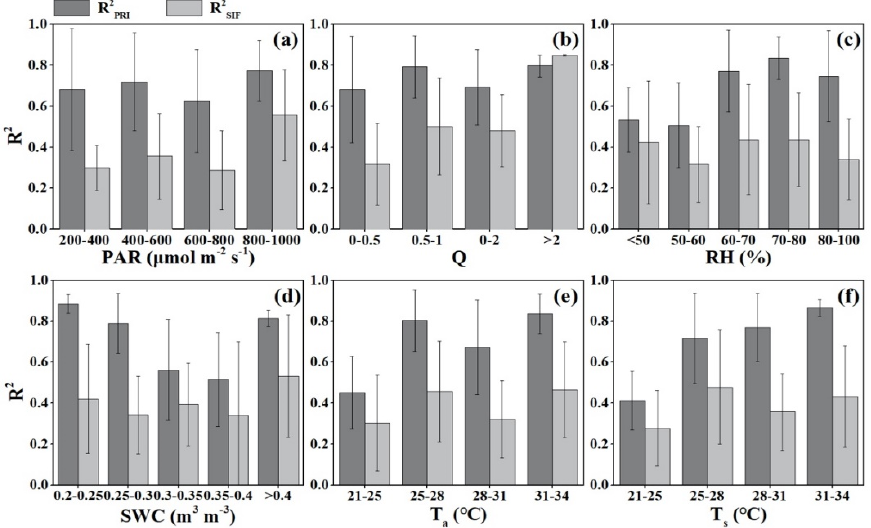
Figure 7. Distribution of R 2 PRI and R 2 SIF under the classified ( a ) PAR, ( b ) Q, ( c ) RH, ( d ) SWC, ( e ) T a , ( f ) T s . Error bars represent standard deviations of R 2 under the classified ranges of the environmental variations.